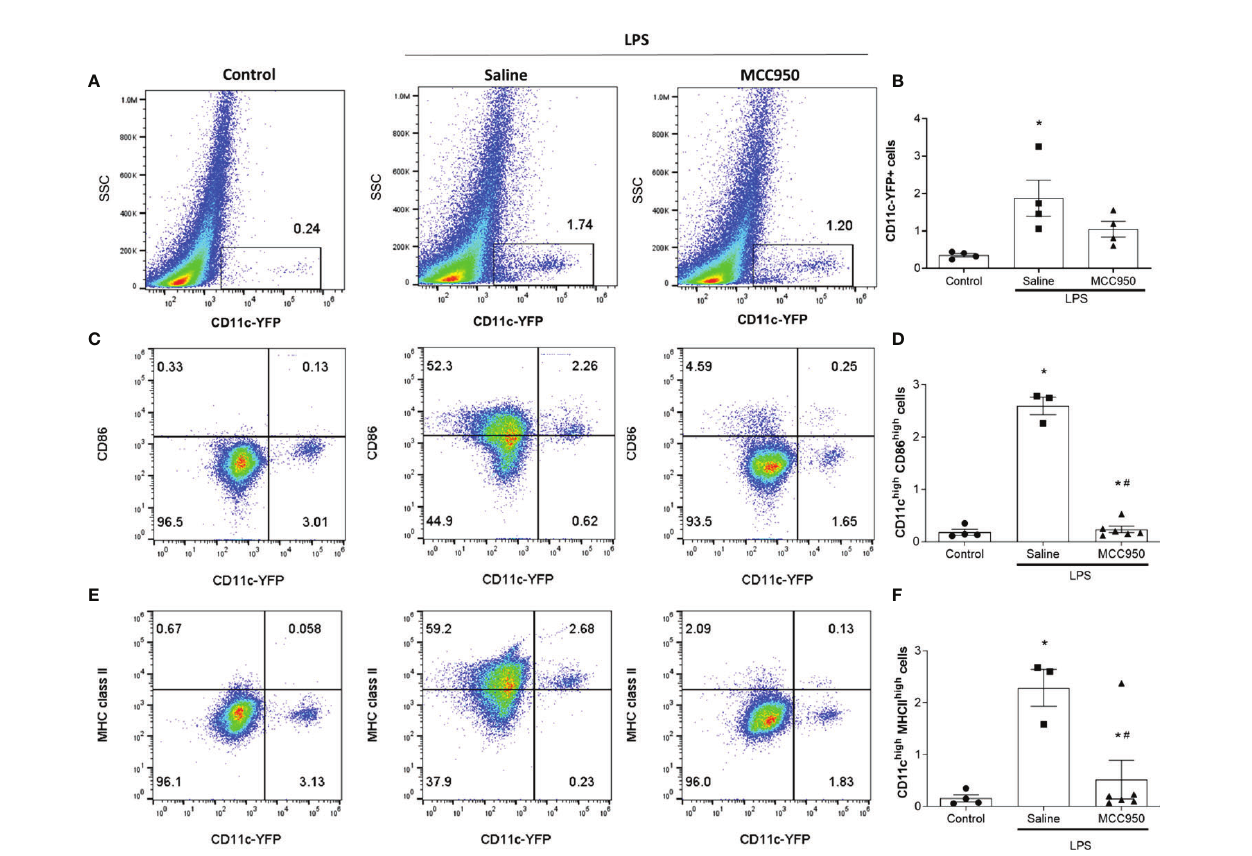
FIGURE 4 | NLRP3 inhibition modulates LPS-induced surface molecule expression in renal CD11c+ cells. (A) Identi fi cation of CD11c-YFP+ cells by fl ow cytometry. (B) The percentage of CD11c-YFP+ cells (n=4 per group). (C) Identi fi cation of CD11c high CD86 high cells. (D) The percentage of CD11c high CD86 high cells (control group, n=4; saline-treated LPS group, n=3; MCC950-treated LPS group, n=6). (E) Identi fi cation of CD11c high MHCII high cells. (F) The percentage of CD11c high MHC class II high cells (control group, n=4; saline-treated LPS group, n=3; MCC950-treated LPS group, n=6). Data are represented as the mean ± SEM. * P <0.05 versus the normal control, # P <0.05 versus the saline-treated LPS group. SSC, side